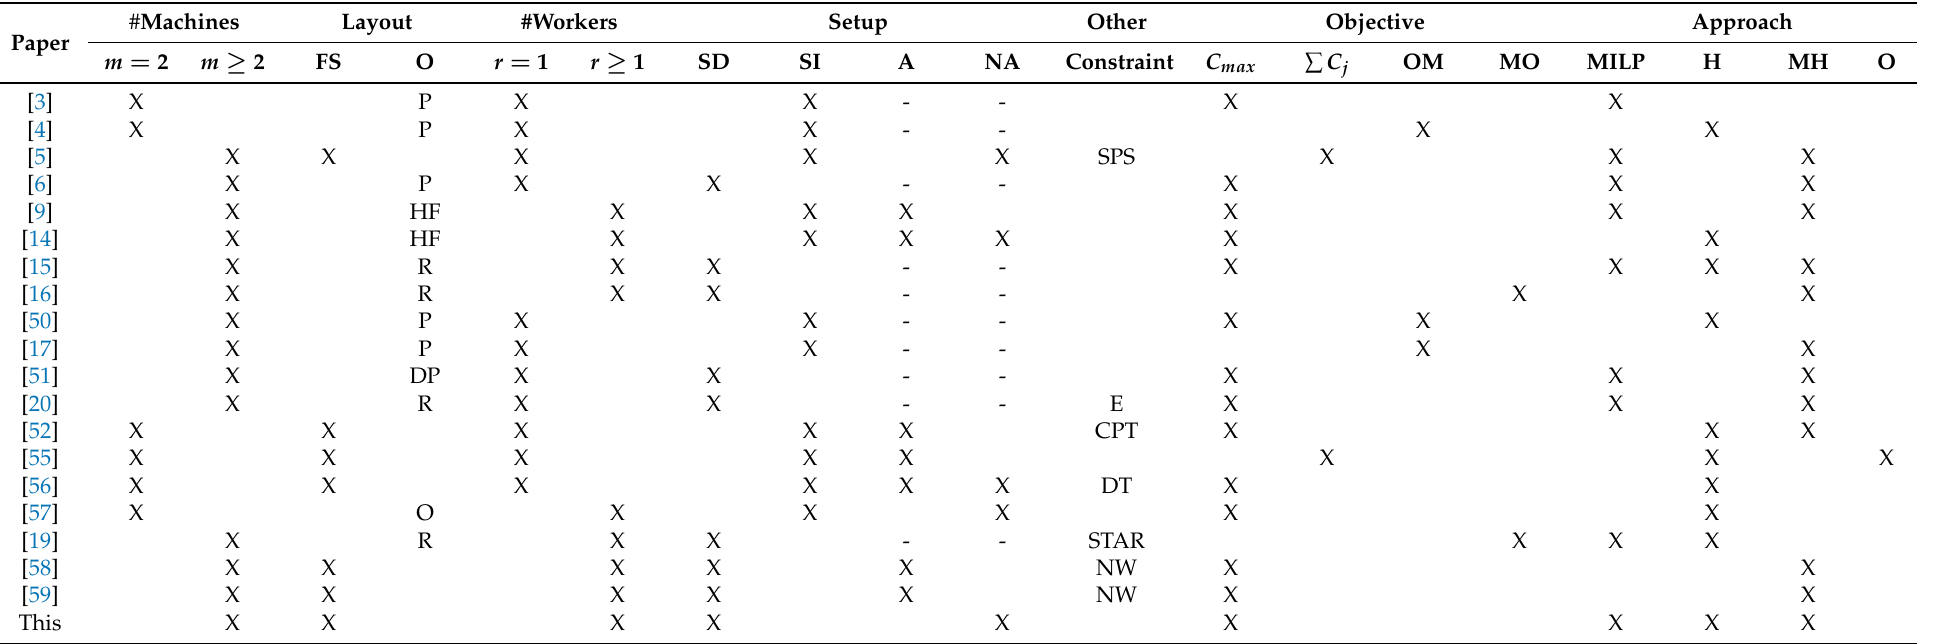
Table 1. Summary of the literature